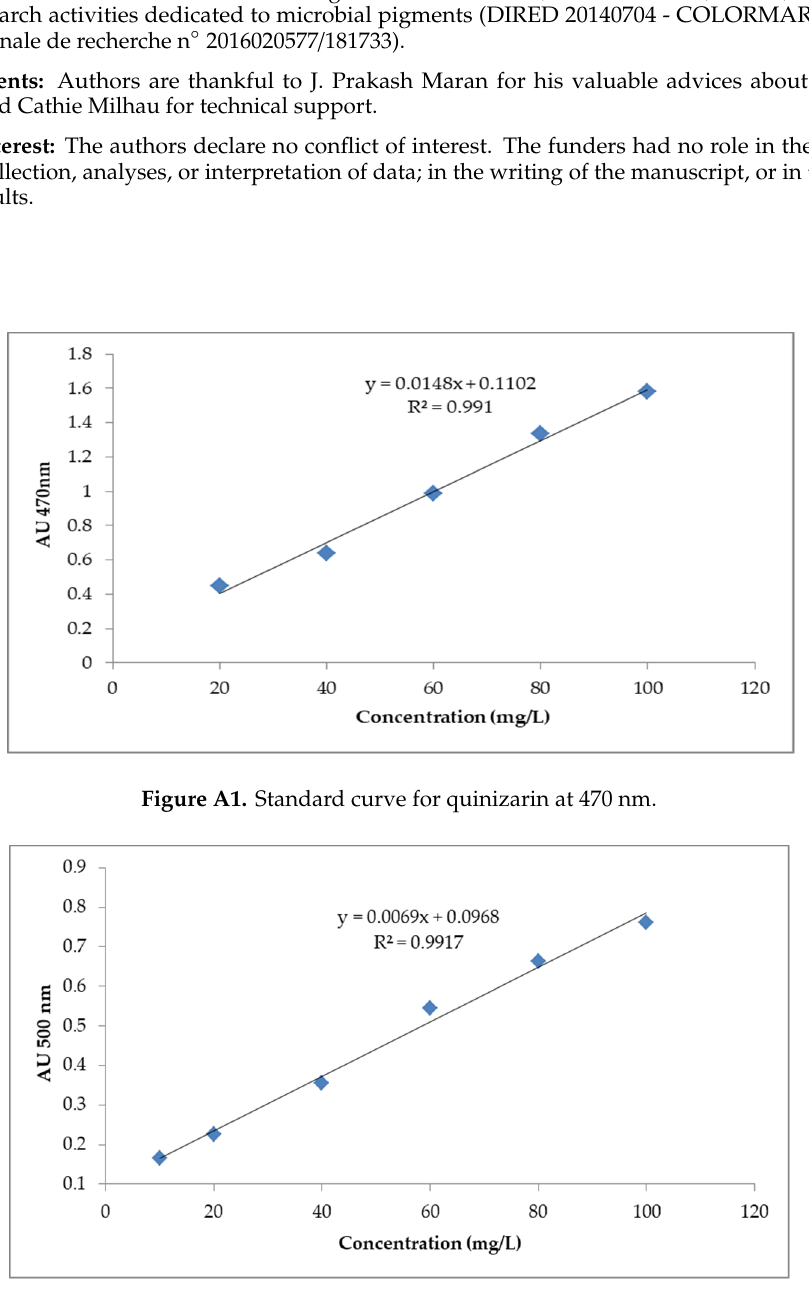
Figure A2. Standard curve for red yeast rice pigment (RYrp) at 500 nm.